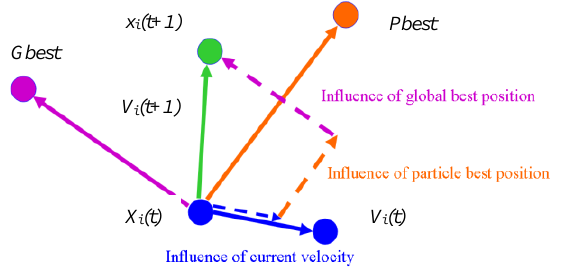
Figure 1. Searching diagram of PSO